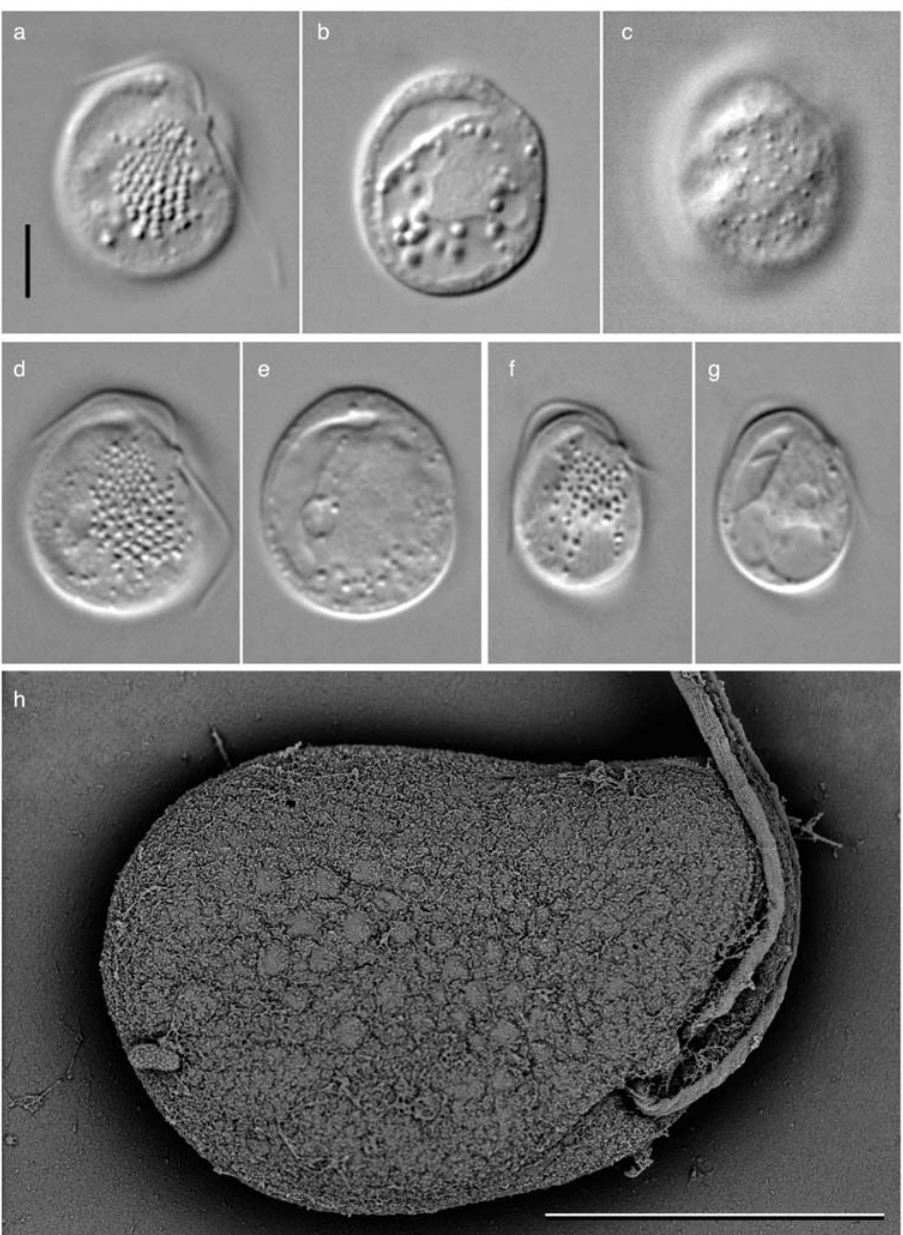
Figure 1. Light and scanning electron micrographs of Roombiatruncata. sp. nov. a – c . Holotype of R. truncata ; d – e a cell showing size close to the maximum size; f – g . a cell showing size close to the minimum size. The ventral side ( a , d , f ) of the cell has 5–11 rows of conspicuous ejectisomes, whose diameter ranging from c.a. 0.3 m m at the anterior end and 0.7 m m at the posterior end. Smaller ejectisomes are also present on the dorsal face of the cell ( c ). A cell has the anterior and posterior flagella emerging from a papilla like structure of the ventral left subapical region ( a , d , f ), and food vacuole along the right margin of the cell ( b , e , g ). ( h ). scanning electron micrograph showing ventral side of the cell. Note multiple rows of ejectisomes. Scale bar=5 m